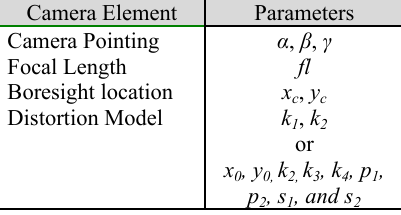
Table 1. Camera model elements and corresponding parameters.